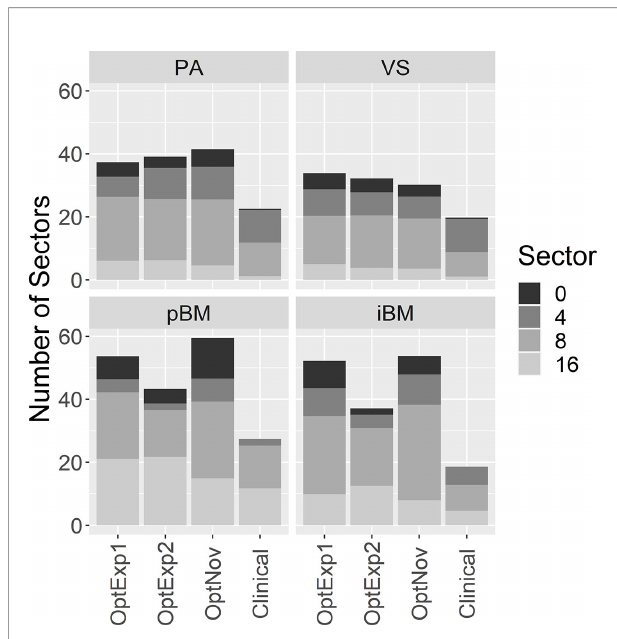
FIGURE 3 | Comparison of the average number of shots and the distribution of different sectors used per plan. PA, pituitary adenoma; VS, vestibular schwannoma; pBM, post-operative brain metastases; iBM, intact brain metastases.